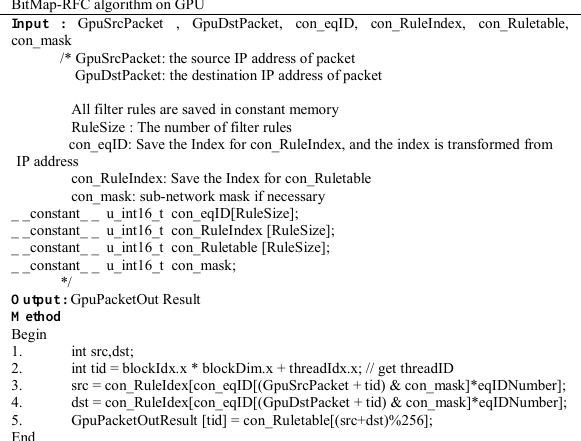
Fig. 8. GPU-based BitMap-RFC algorithm.